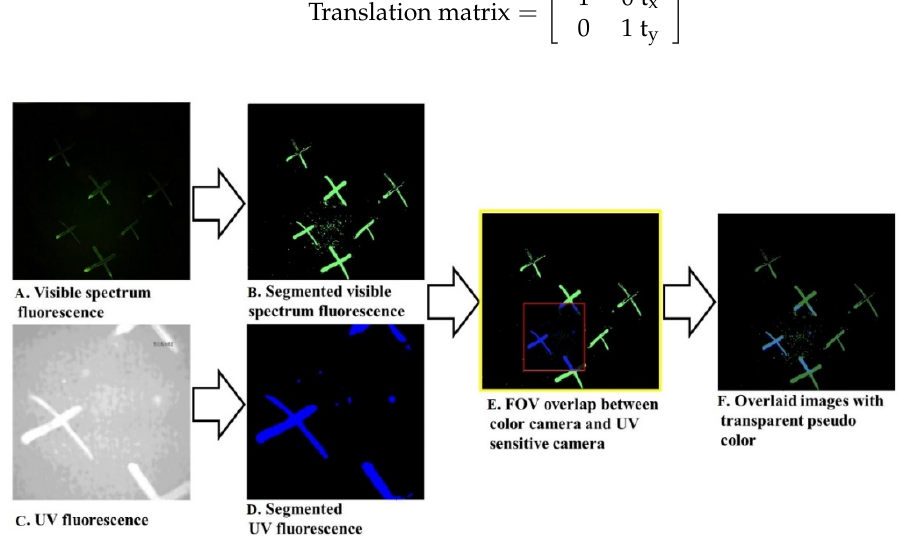
Figure 5. The image overlaying procedure for the registration of UV and RGB cameras with different fields of view. ( A ) The image from the color camera; ( B ) the segmented image from a color image; ( C ) the image from a UV camera; ( D ) the segmented image from a UV image; ( E ) a color camera FOV (yellow frame) versus a UV camera FOV (red frame); and ( F ) the result of the overlaying algorithm with 50% transparency. By cropping the image to the FOV of the UV camera, we can create a fully registered image for all three fluorescence emission